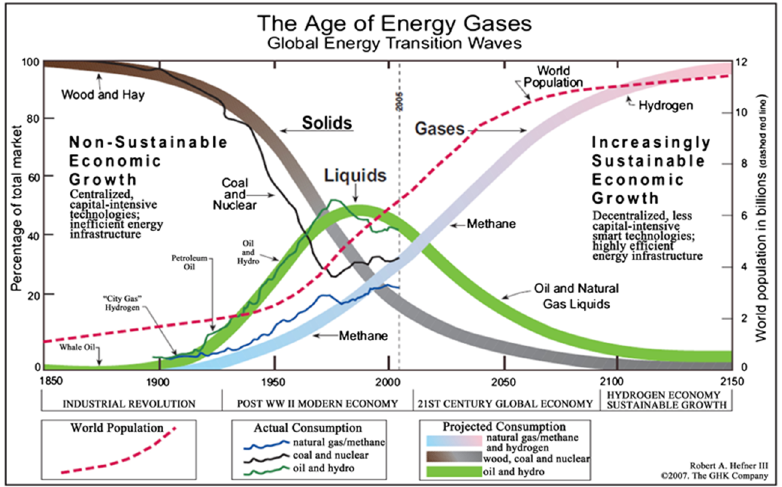
Figure 3. Transition from fossil-based to hydrogen-based energy Reprinted with permission [19].